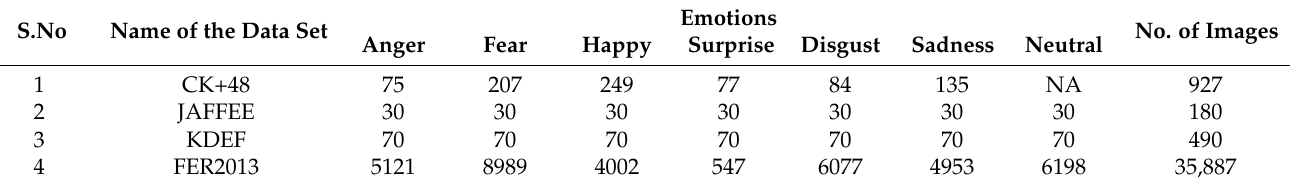
Table 3. Image distribution of